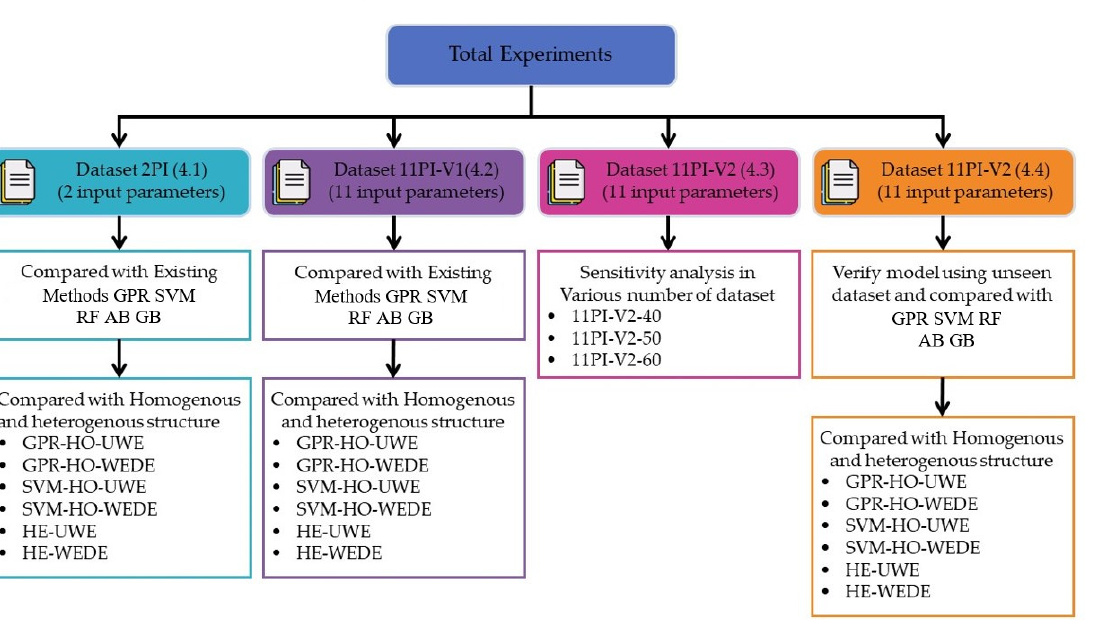
Figure 6. Experimental